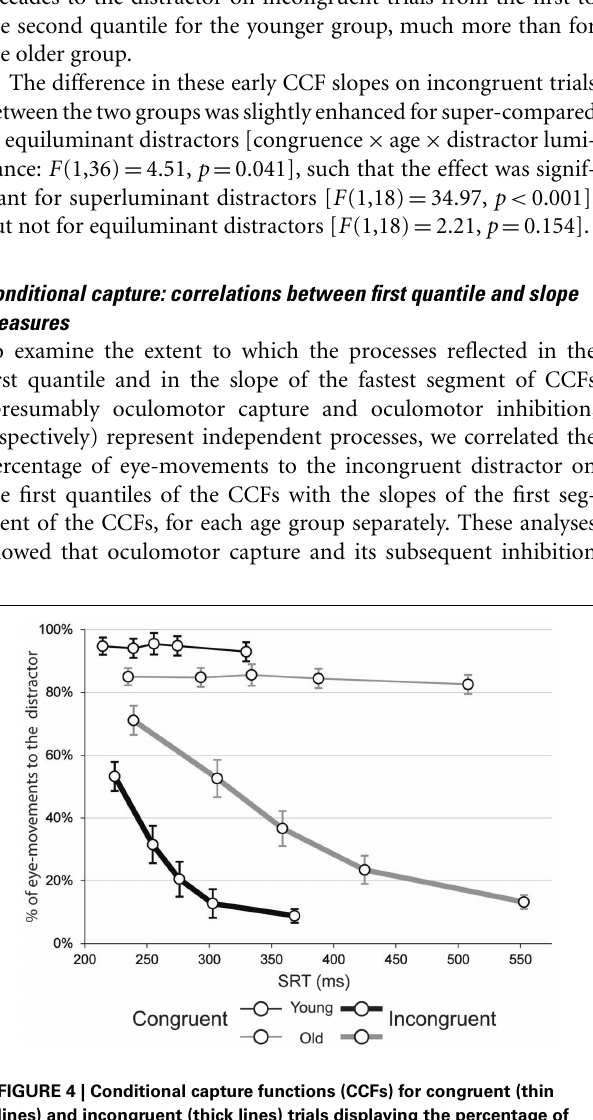
FIGURE 3 | Mean percentage of eye-movements to the distractor for each of the experimental groups. The two left-most bars represent eye-movements to the distractor on congruent trials for young (dark-gray) and old subjects (light gray.The two right-most bars portray incongruent trials. Error bars represent the SEM.